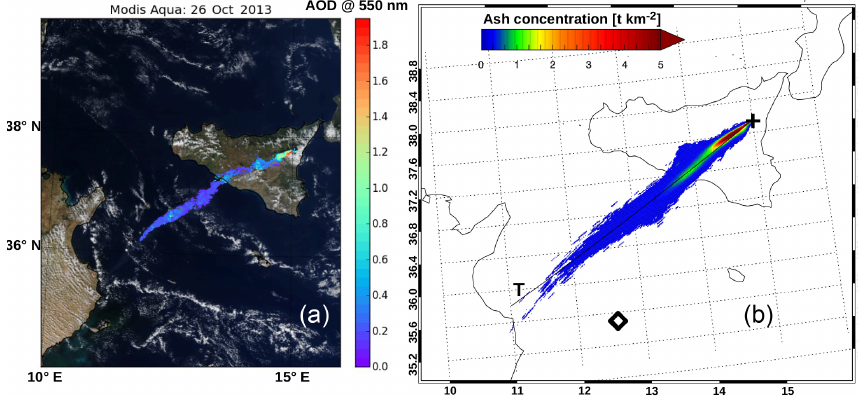
Figure 9. (a) Ash optical depth at 550nm from Aqua-MODIS overpass of 26 October 2013, 12:20 UTC; (b) total ash column abundance (in tkm − 2 ) from FLEXPART simulations. The ash classes 3, 4 and 5 (see Table 1) are added up to compare with MODIS observations. Blue to red pixels indicate relatively low to high optical depth (panel a ) and abundance values (panel b ). The position of Lampedusa is indicated with a black diamond in (b) ; the position of Mount Etna is indicated with a black cross in (b) .